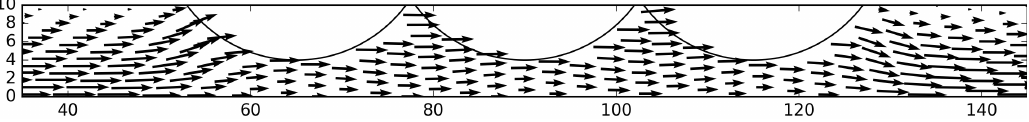
Figure 13. Velocity vectors for 3 rollers, c = 5 mm/s, L = 180 mm, RO = 0.6 and n = 1.